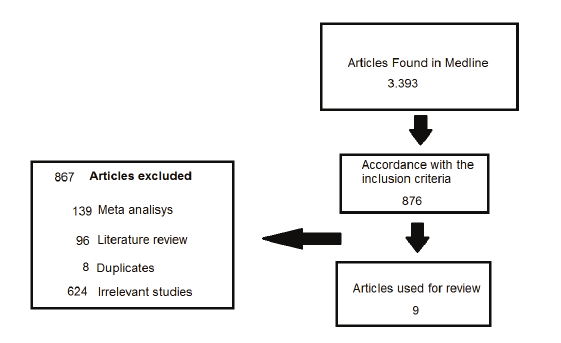
Figure 1 - Algorithm the database